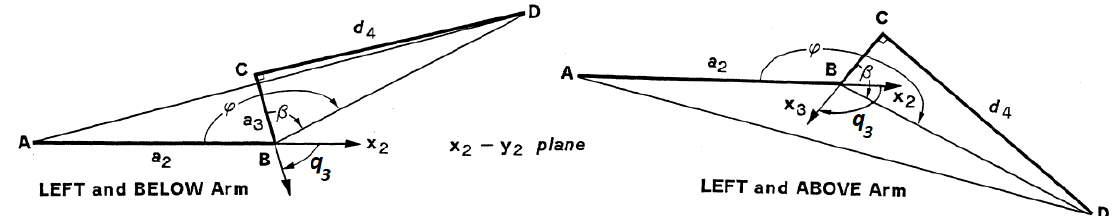
Figure 5. Geometric solution for joint 3 ( q 3 ), showing two of the possible four configurations: “LEFT and BELOW Arm” ( left ) and “LEFT and ABOVE Arm” ( right ) [3].